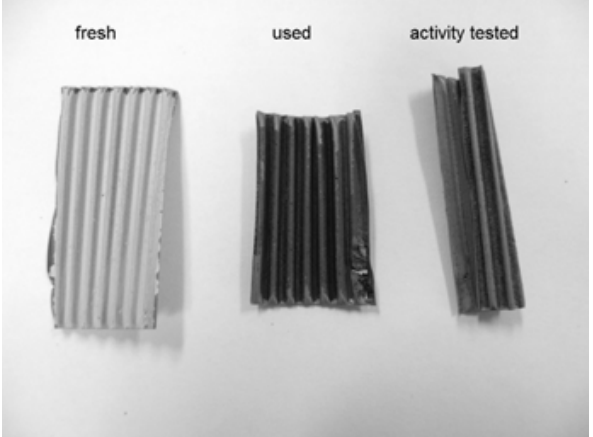
Figure 11. The sections of the diesel oxidation catalyst sheets: fresh, vehicle-aged and performance- tested.